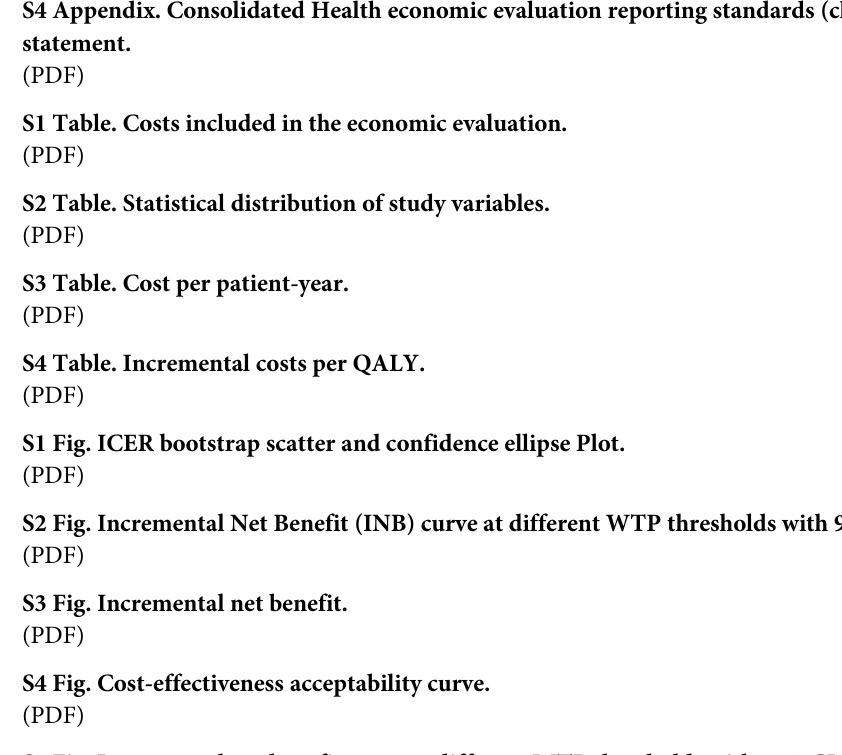
S1 Table. Costs included in the economic